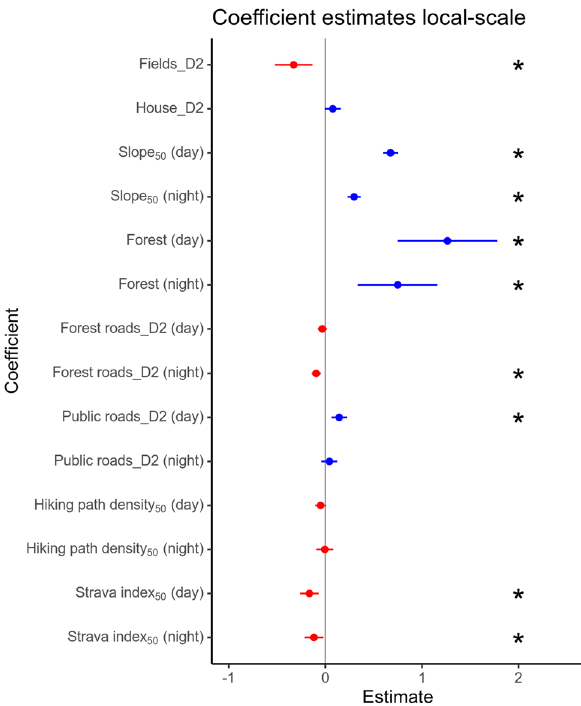
Figure 5. Selection coefficients for local-scale habitat selection. The point estimates and 95% confidence intervals based on the robust standard errors for the local-scale RSF models. Red colours indicate negative value of the estimate and blue colours indicate positive values of the estimate. D2 is an abbreviation for “distance to”, all “distance to” features have been log-transformed to make the effect decrease with large distances. Note that a positive estimate for distance to feature indicates avoidance (selecting for areas farther away for the feature). Stars indicate significant estimates at the alpha level of